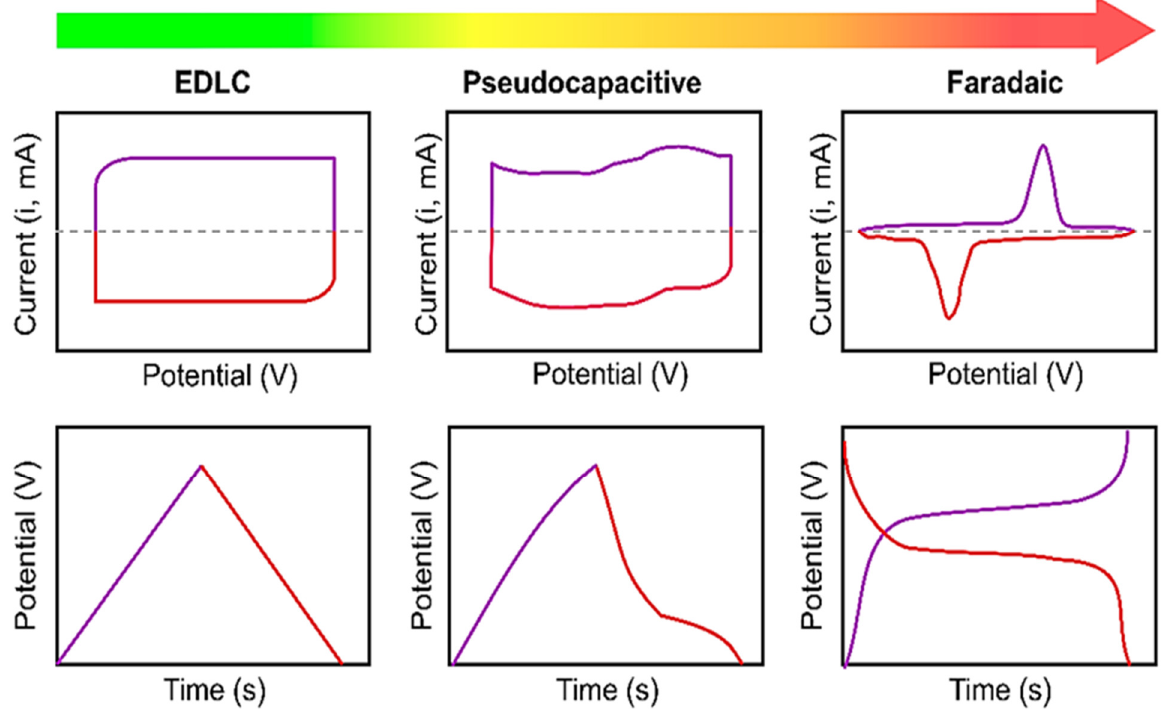
Figure 5. Schematic of typical CVs and corresponding charge-discharge curves of EDLC, pseudo- capacitor, and battery-type materials [39], open access.